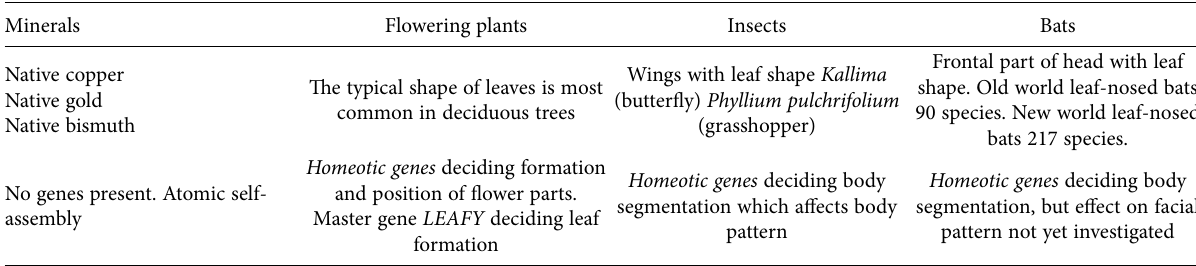
Table 5. Occurrence of structures with leaf shape from minerals to bats.